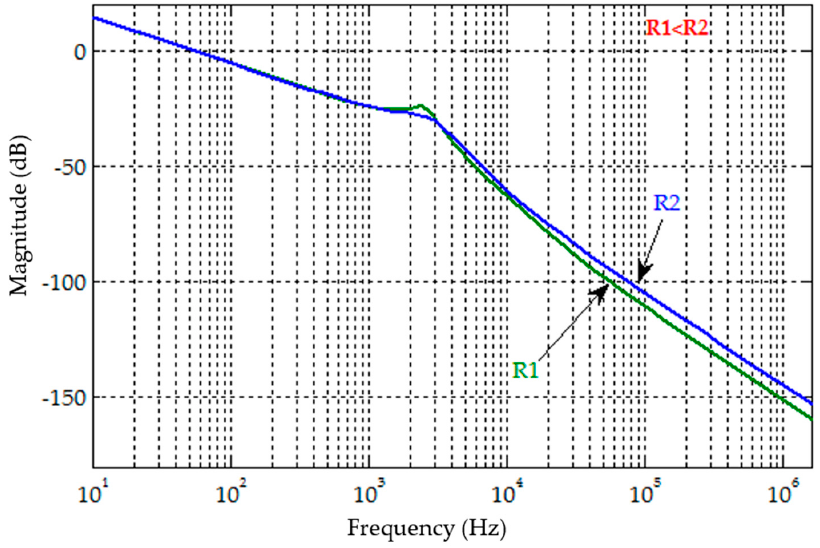
Figure 10. Frequency response characteristics for varying R r with resistance ratio constant.